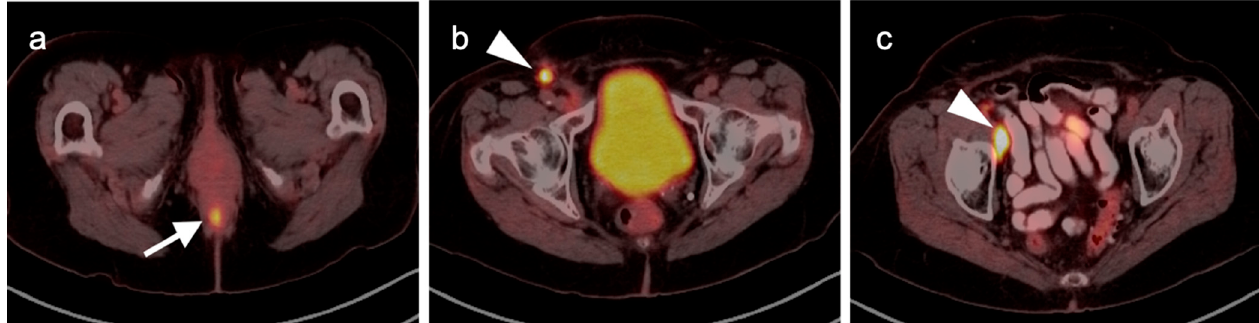
Figure 39. Anal cancer. Axial fused FDG PET-CT images of the pelvis. ( a ) Small primary tumor just within the anus (white arrow); ( b ) Nodal spread of tumor to a small but intensely hypermetabolic right inguinal node, (white arrowhead); ( c ) A right distal external iliac node (white arrowhead).